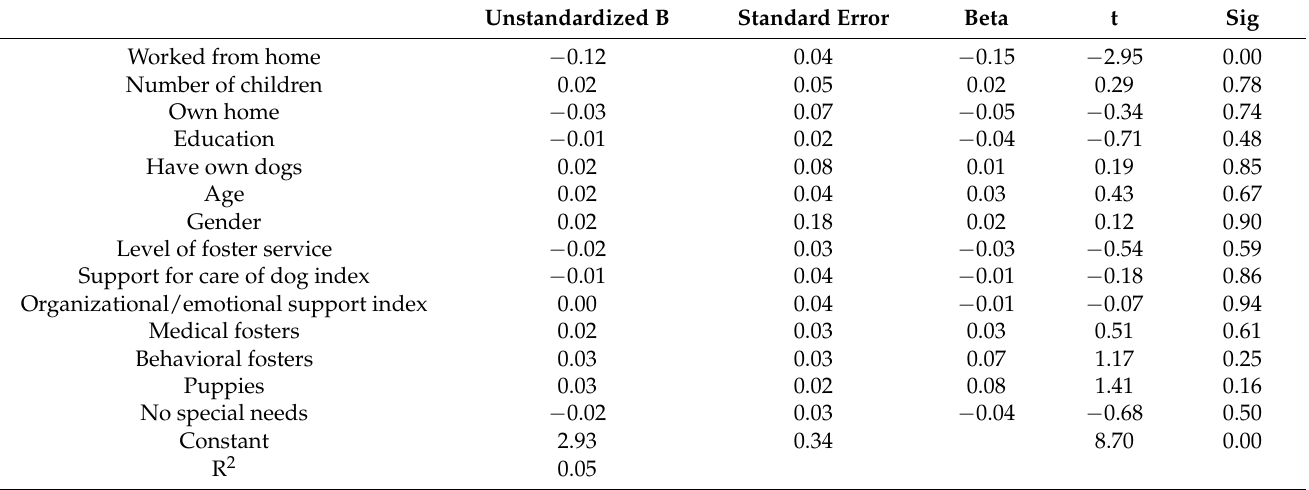
Table 8. Regression: level of service expected after COVID-19 has been